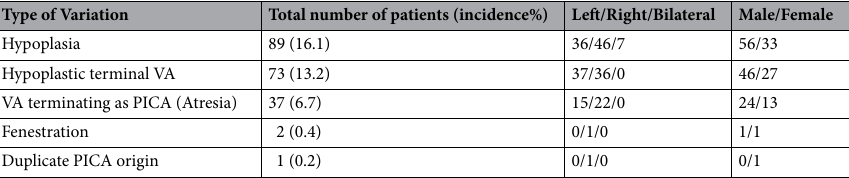
Table 1. Incidence of anatomical variations at the intracranial segment (V4) of the VA diagnosed by MDCTA.